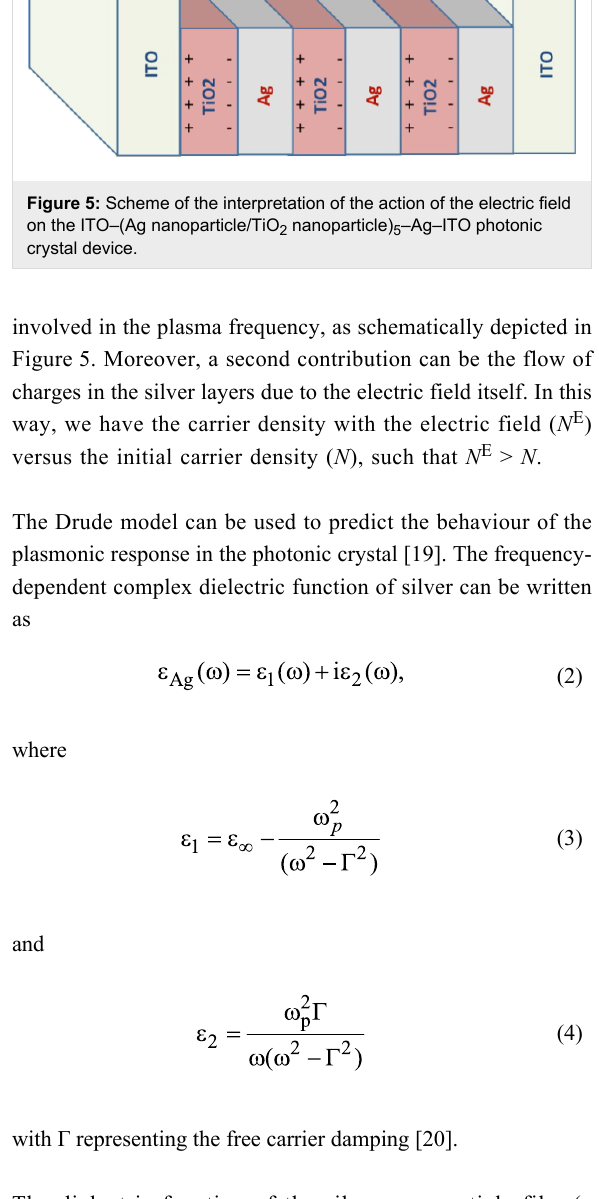
Figure 4: (a) ITO–ITO device under electric field; (b) ITO–Ag nanopar- ticle–ITO device under electric field; (c) ITO–TiO 2 nanoparticle–ITO device under electric field.